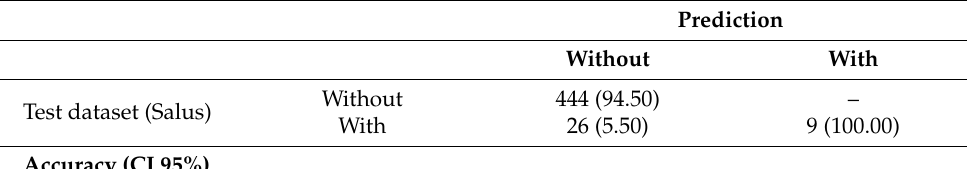
Table 3. Confusion matrix (Salus dataset as test dataset) on sarcopenia status.